Question: Which kind of chart has been used to present this data?
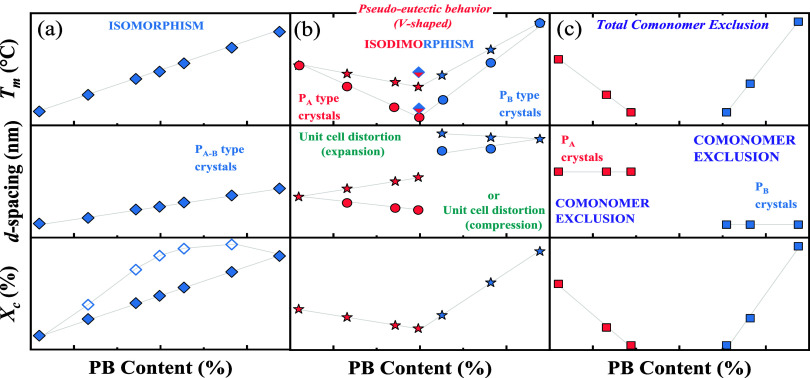
Answer: line